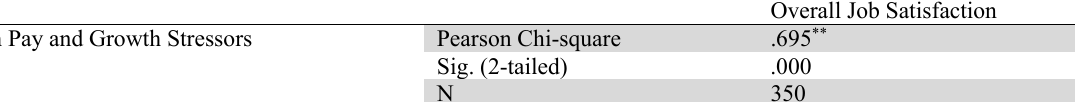
Chi-square tests for Pay & Growth Stressors